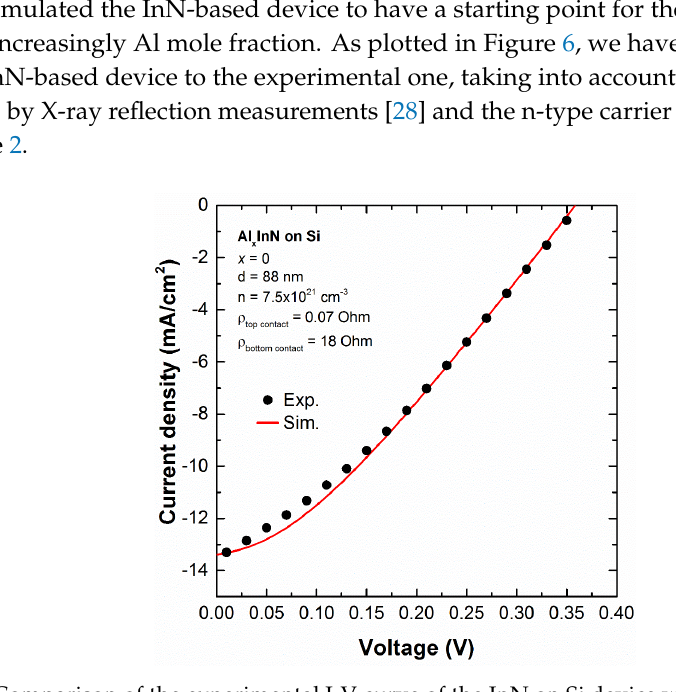
Figure 6. Comparison of the experimental J-V curve of the InN on Si device with the simulated one with PC1D program taking into account the simulation parameters from the inset.